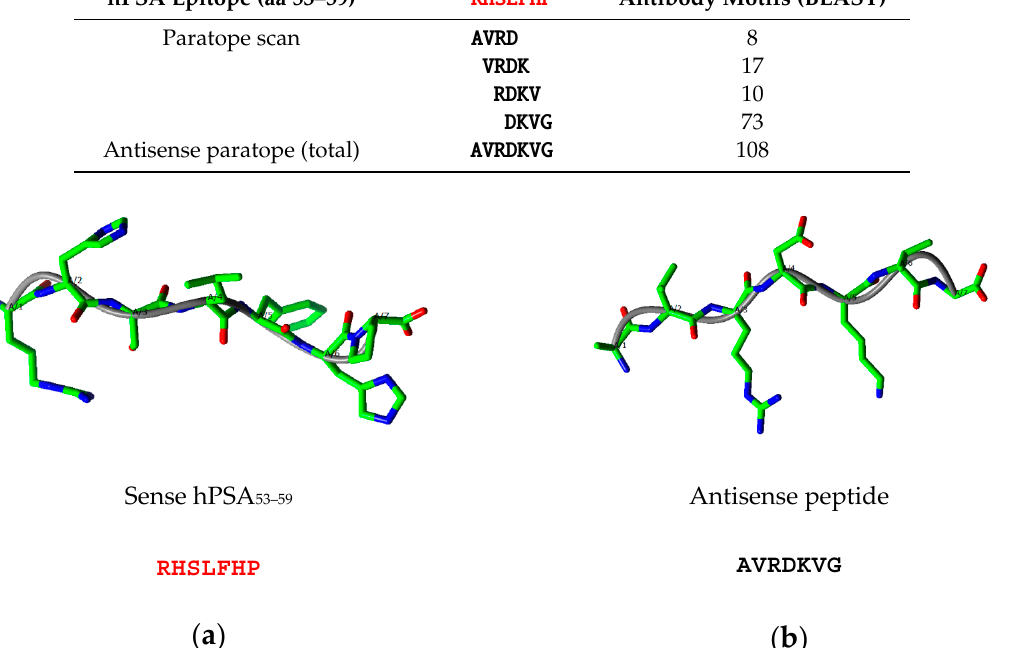
Figure 2. Predicted structures of ( a ) sense hPSA peptide epitope RHSLFHP (red) and ( b ) antisense peptide paratope AVRDKVG obtained with the PEPstrMOD method [ 46 ] .